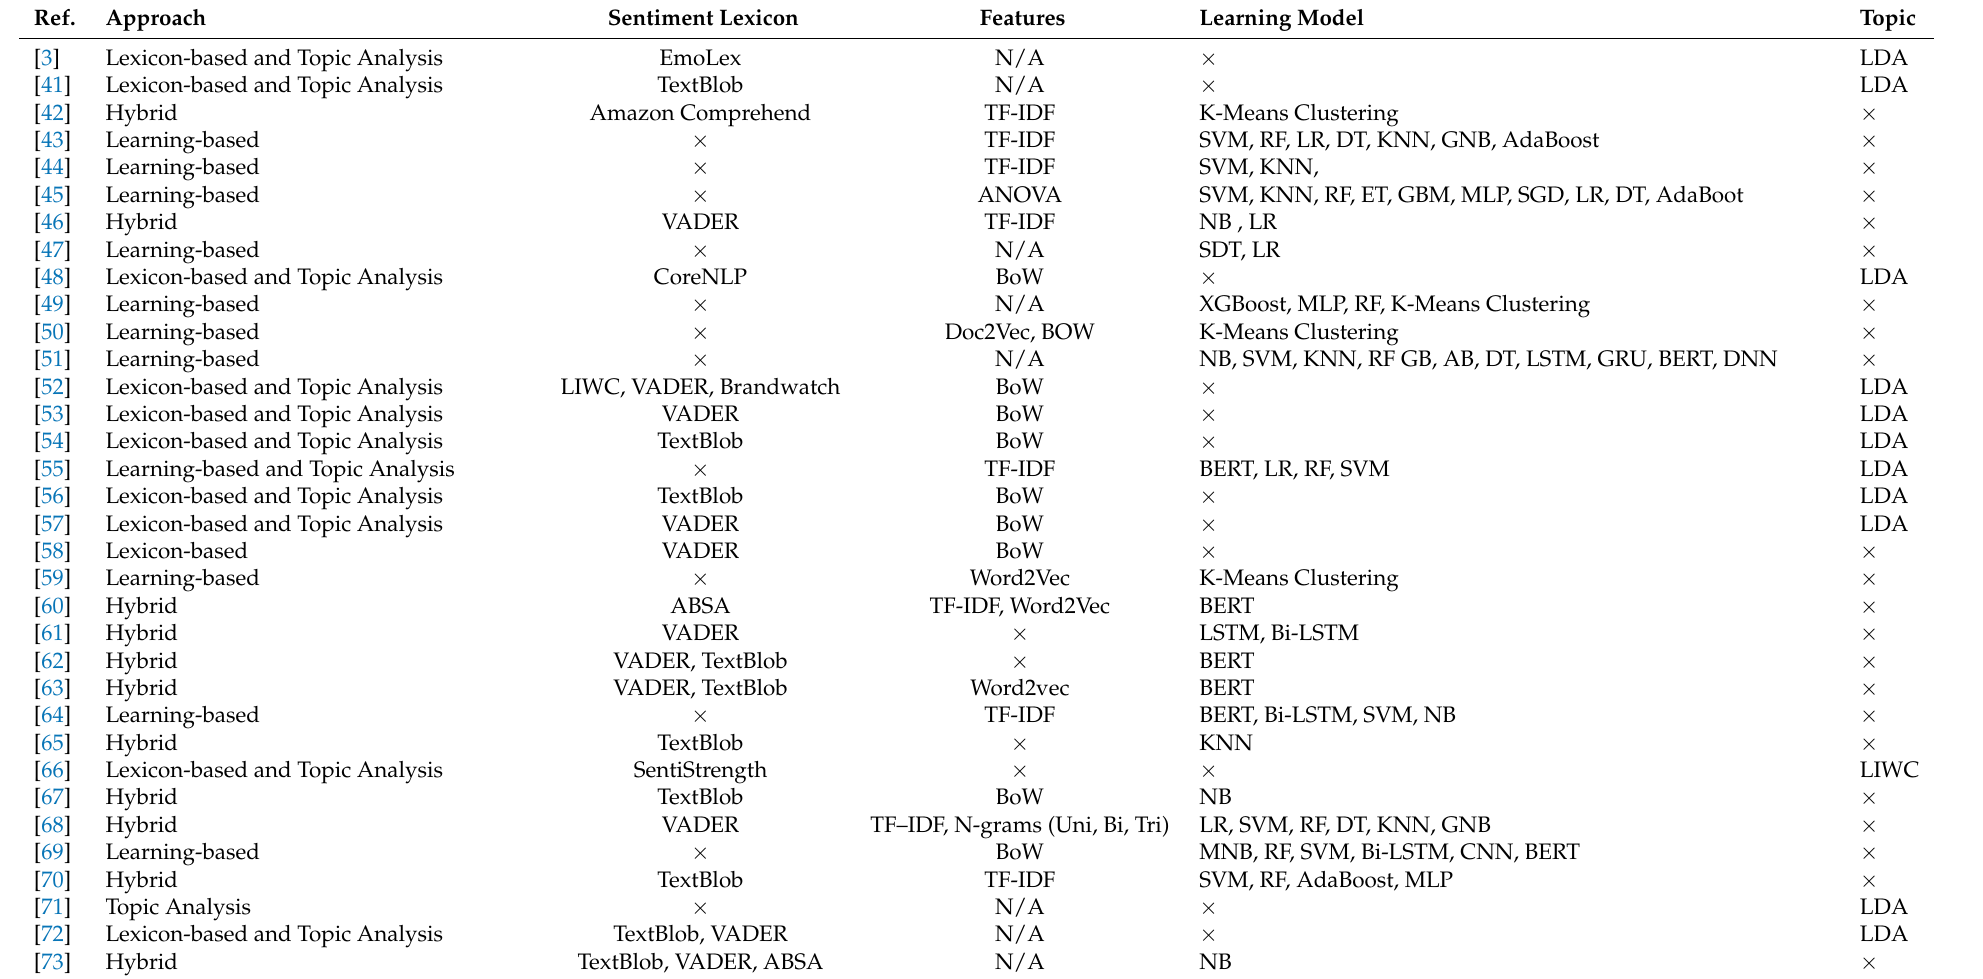
Table 3. Summary of approaches for screening of people’s perception for COVID-19 vaccine